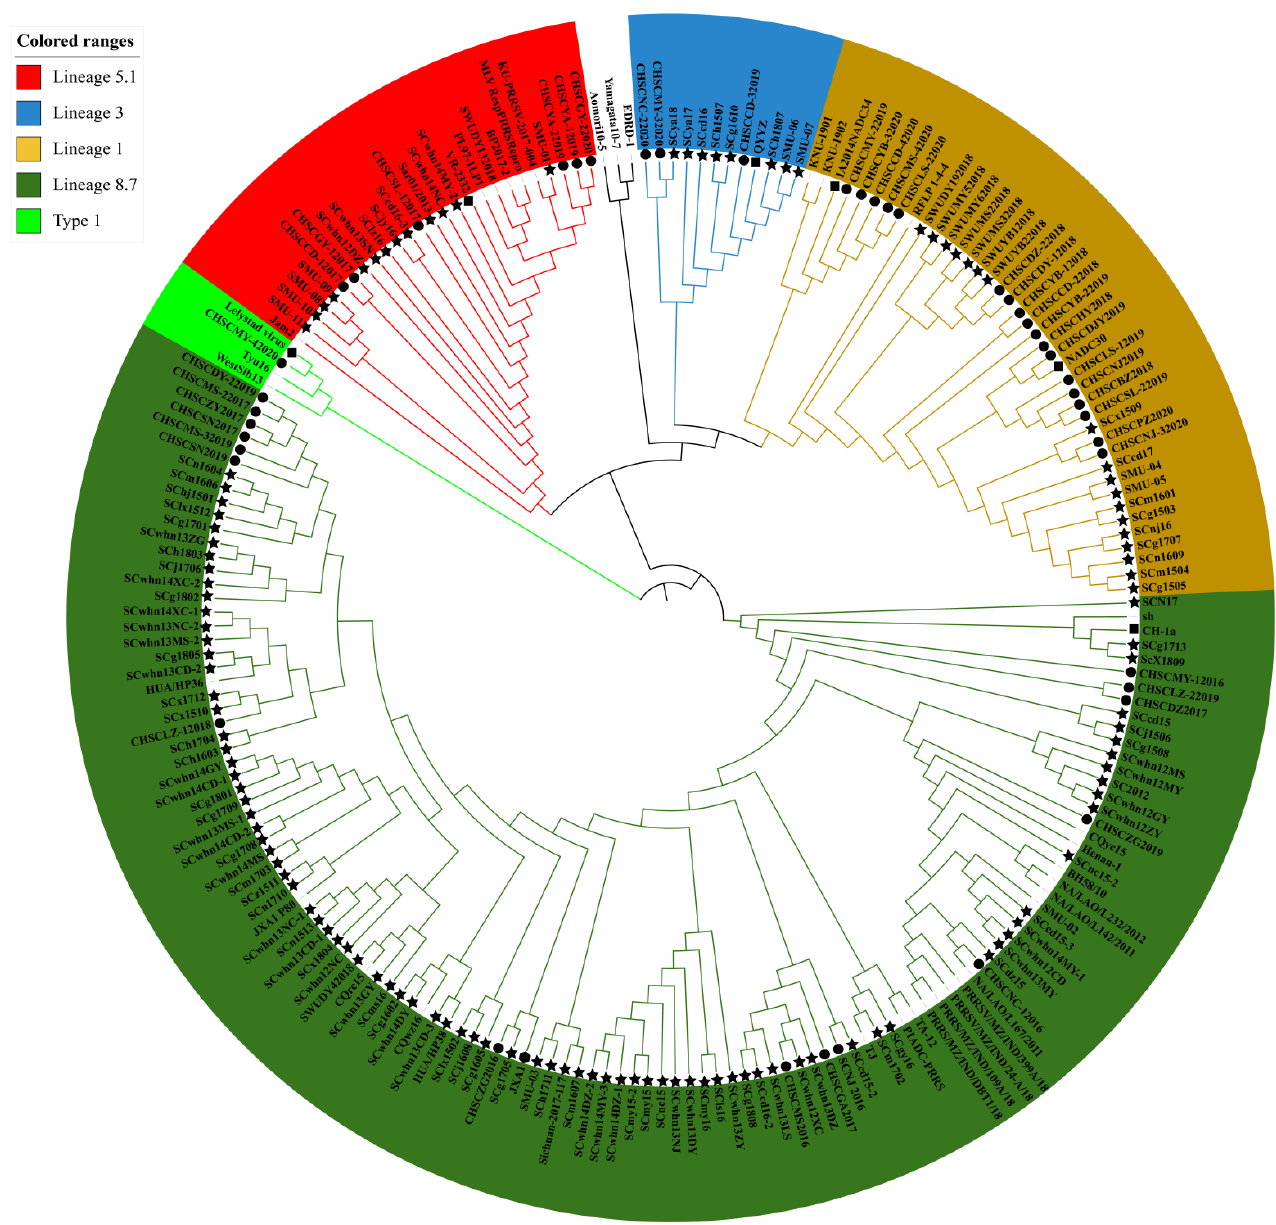
Figure 1. Phylogenetic analysis based on ORF5. The black dot represents PRRSV strains identified in this study, the black star diagram represents PRRSV strains from Sichuan in GeneBank from 2012 to 2020 and the black square represents PRRSV reference strains. Unmarked are current prevalent strains from other regions of China or other countries.